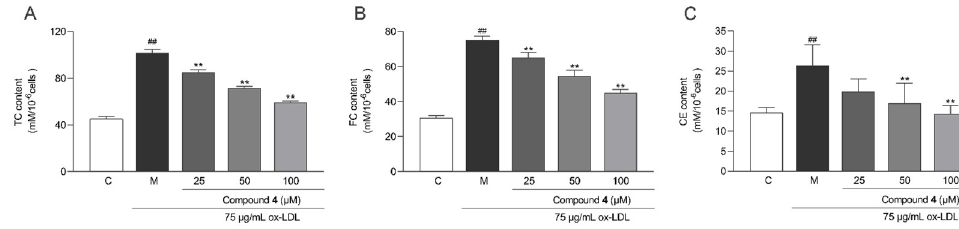
Figure 10. Inhibitory effect of compound 4 on the intracellular contents of ( A ) total cholesterol (TC), ( B ) free cholesterol (FC), and ( C ) cholesterol ester (CE) in RAW264.7 cells (mean ± SD, n = 3). Statistical analysis: ## p < 0.01 vs. the control group; and ** p < 0.01 vs. the ox-LDL-treated model group. C: control group; M: model group.